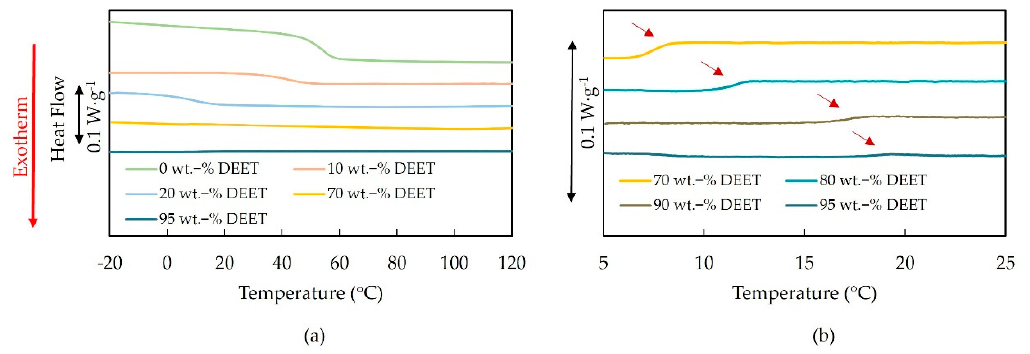
Figure 3. Differential scanning calorimetry (DSC) cooling curves (2 K · min − 1 ) of the PDLLA-DEET system at different heat-flow rate scales: ( a ) exhibiting the glass transition of the low-DEET-content samples; ( b ) exhibiting the demixing peaks of high-DEET samples.